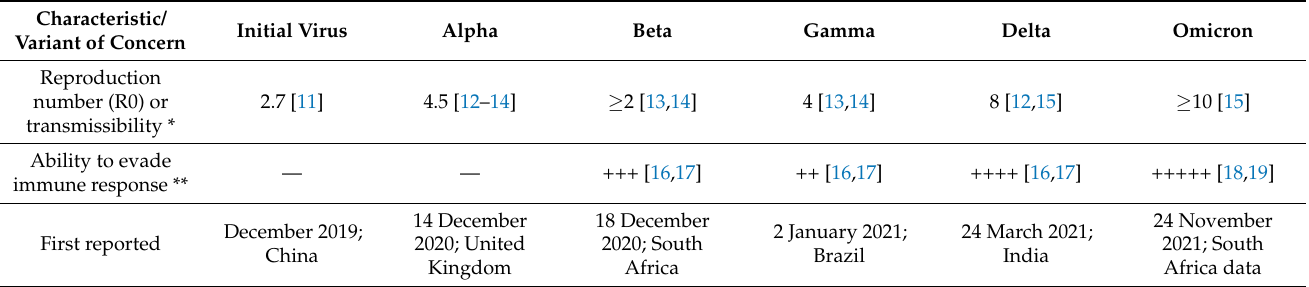
Table 1. Comparative characteristics between initial SARS-CoV-2 and variants of